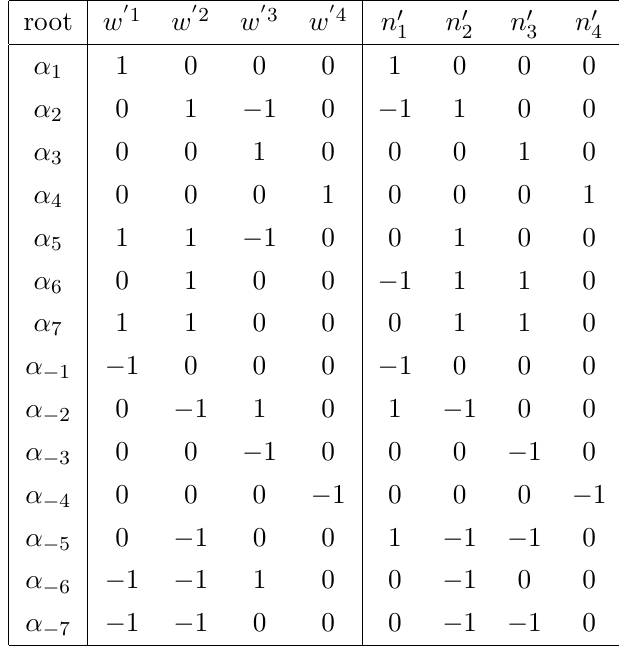
the vectors associated to (cid:11) 0 associated to (cid:11) 0 from SU(2) (cid:2) SU(2) (cid:2) SU(2) once we identify x 0 1